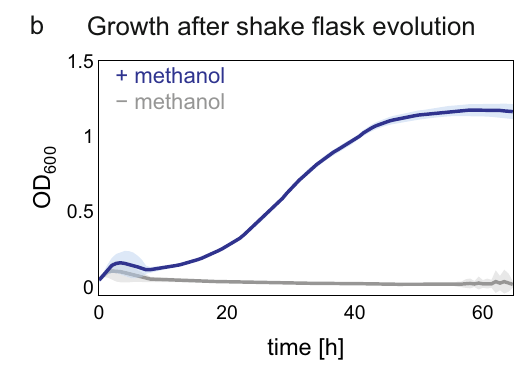
methanol. Growth was examined by measuring absorbance at 600nm in a micro- platereader.ThemeasuredabsorbancevalueswereconvertedtoOD 600 valuesbya calibration curve. Shown are the mean of 10 technical replicates and the standard deviation error band around the mean. Source data are provided as a Source Data fi